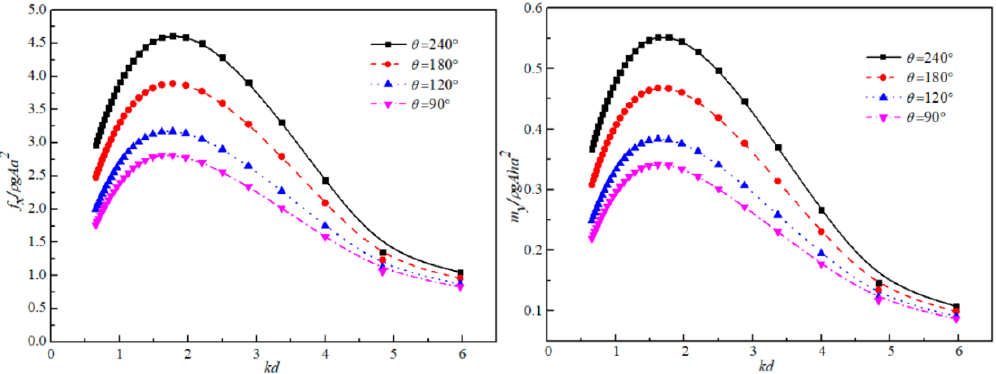
Figure 12. Variation of the wave force and the bending moment on the outer cylinder with different baffle wall angles.